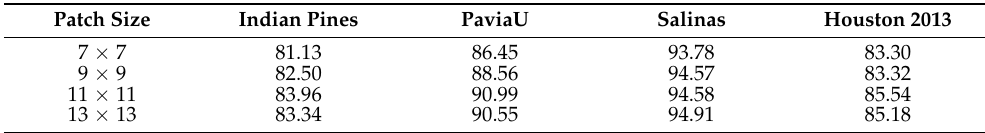
Table 10. OA(%) of the SSRNet with various patch sizes.